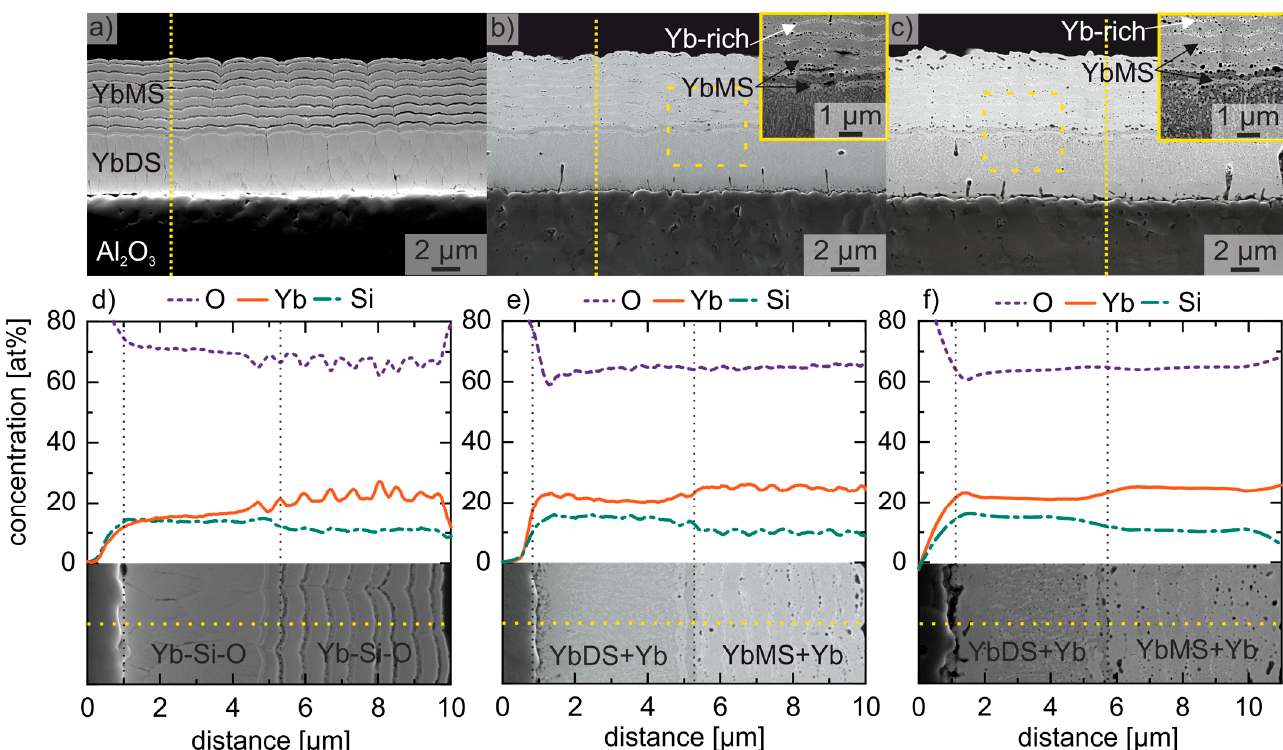
Figure 5. Secondary electron SEM micrographs of the Yb-silicate coatings on an Al 2 O 3 substrate; ( a ) after the deposition process in the as-coated state; ( b ) after crystallisation treatment for 1 h at 900 °C followed by 1 h at 1200 °C in lab air; ( c ) after an additional 10 h of oxidation testing at 1200 °C in lab air. EDS linescan with secondary electron micrographs of the Yb-silicate coatings on top of an Al 2 O 3 substrate; ( d ) after deposition in the as-coated state; ( e ) after crystallisation for one hour at 900 °C and one hour at 1200 °C in air; ( f ) after 10 h of oxidation test at 1200 °C.